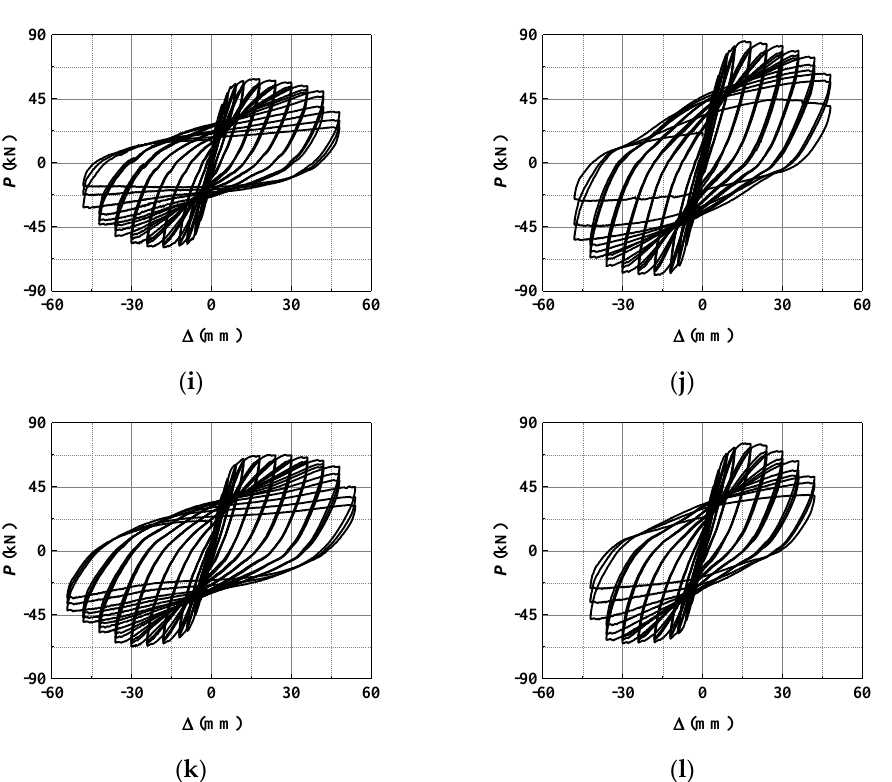
Figure 20. Hysteresis characteristics of the specimens. ( a ) JP-F0. ( b ) JP-F1. ( c ) JP-F2. ( d ) JP-F3. ( e ) JP-F4. ( f ) JP-F5. ( g ) JP-A0.225. ( h ) JP-A0.3. ( i ) JP-L12. ( j ) JP-L16. ( k ) JP-J50. ( l ) JP-J100.